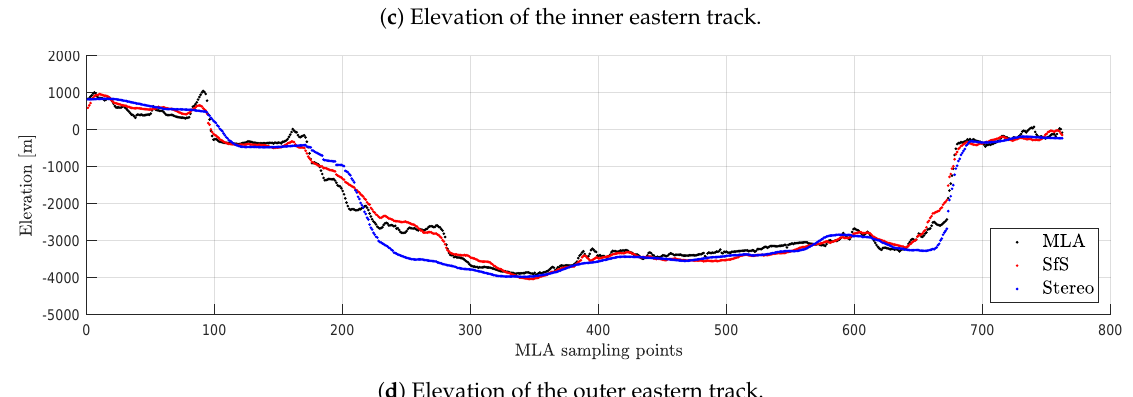
Figure 14. Comparison of the MLA tracks (black) to the surface constructed by the SfS procedure (red) and the initial stereo DTM (blue) of the Rachmaninoff basin. The positions of the tracks are given in Figure